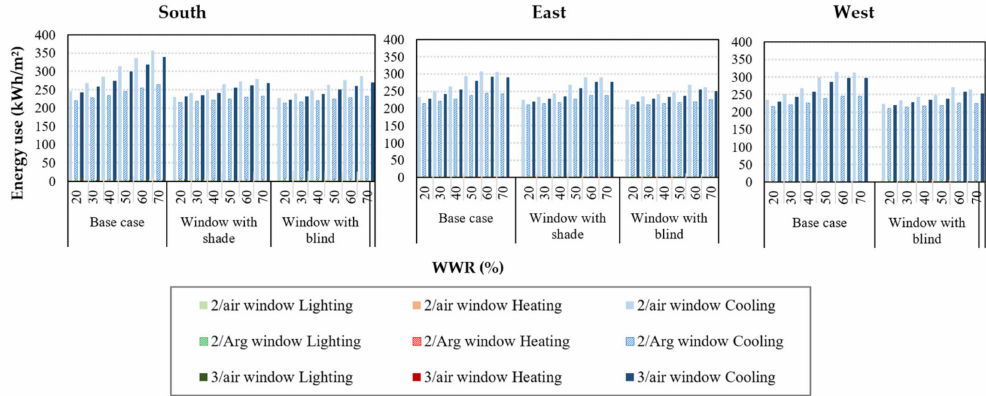
Figure 9. Lighting, cooling, and heating energy use as a function of WWR (%) for three window types (2/air, 2/Arg, and 3/air windows) for south, east and west orientations of buildings located in Hot, arid, desert climate